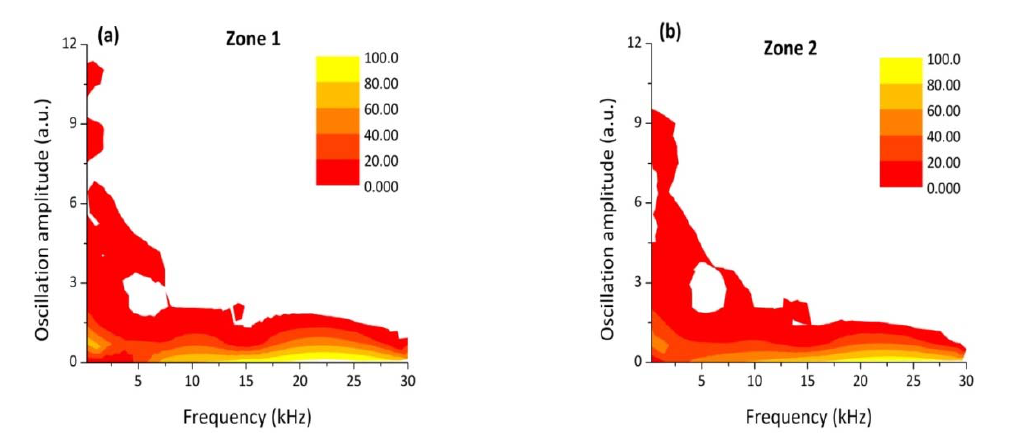
Figure 7. Relative oscillation amplitude of the frequency bands of the photodiode signal acquired during a welding process performed with decreasing laser power (Zone